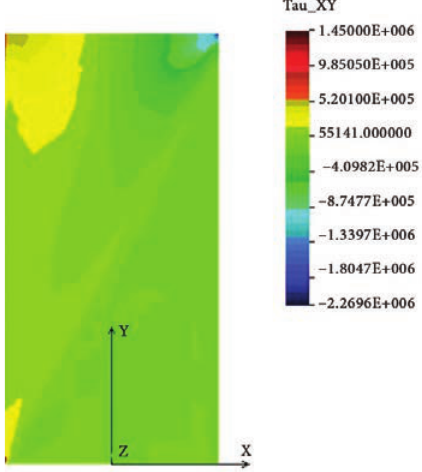
Fig. 6. Distribution of shear stress component τ xy in the sample with free ends